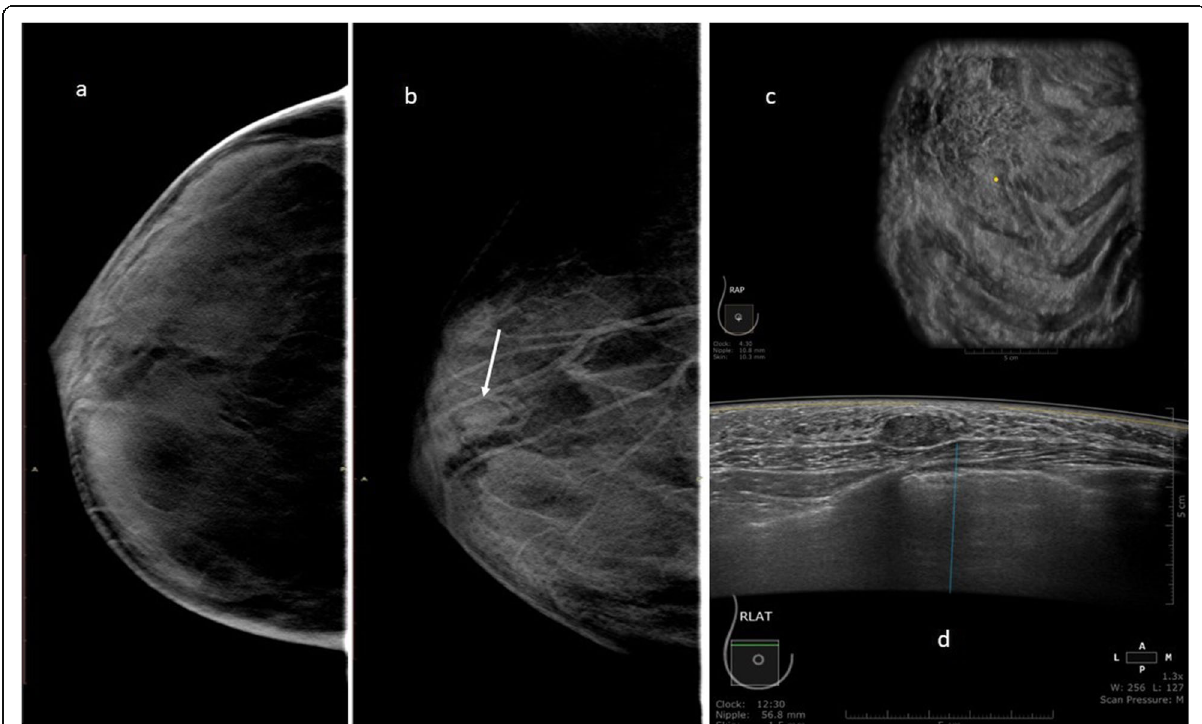
Fig. 4 A 36-year-old female patient was referred to the early detection breast clinic with a strong family history of breast cancer. Tomosynthesis CC and MLO views ( a , b ) of the right breast show a UOQ oval-shaped circumscribed high-density mass (BIRADS III) (arrow). c Automated ultrasound right AP coronal image showing rounded spot at distance 10.3 mm from the nipple. d Automated ultrasound right lateral image shows an oval-shaped mass with circumscribed margins, parallel orientation and hypoechoic echo pattern (BIRADS III). The lesion proved to be fibroadenoma by core biopsy. Both modalities were equal in the detection and characterization of the mass